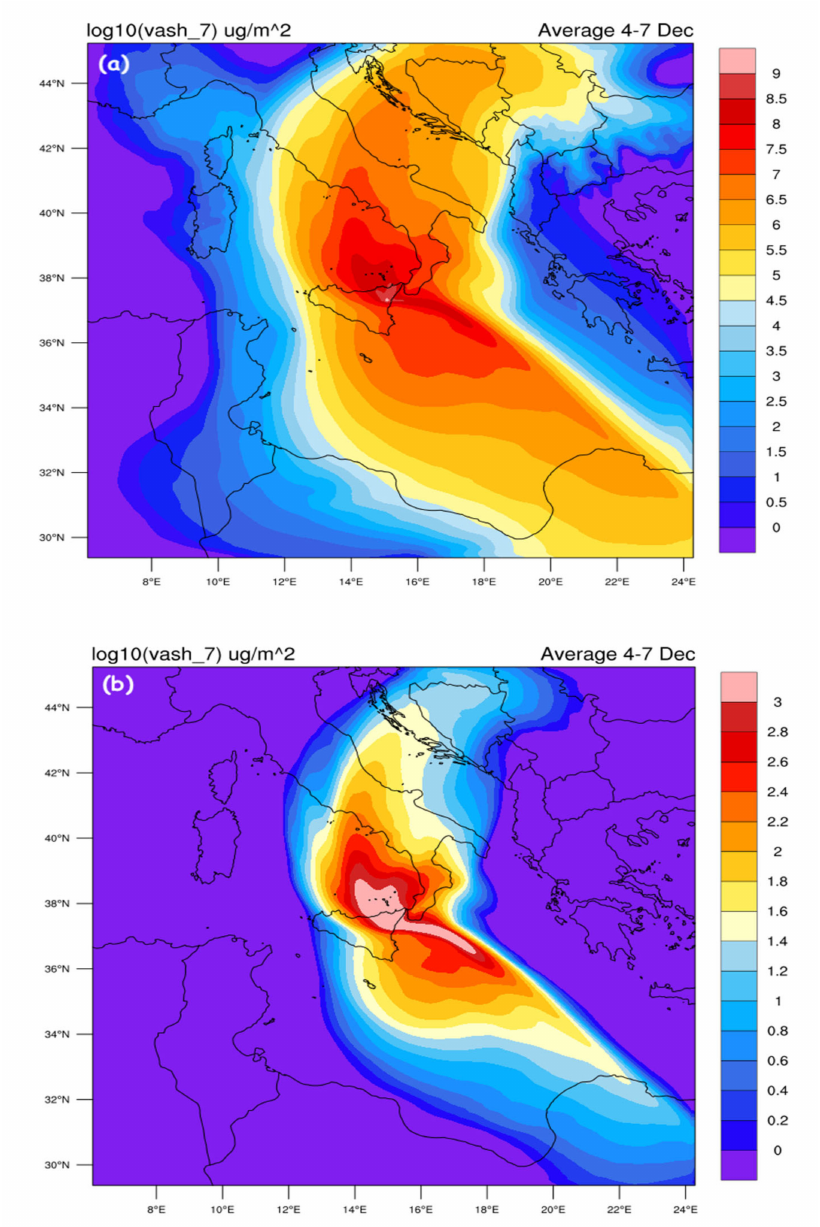
Figure 11. Panel ( a ): distribution of volcanic ash considering vash_7 (not included in the M1 classification) in the average period December 4th–7th. Panel ( b ): distribution of vash_7 exceeding 0.1 g m − 2